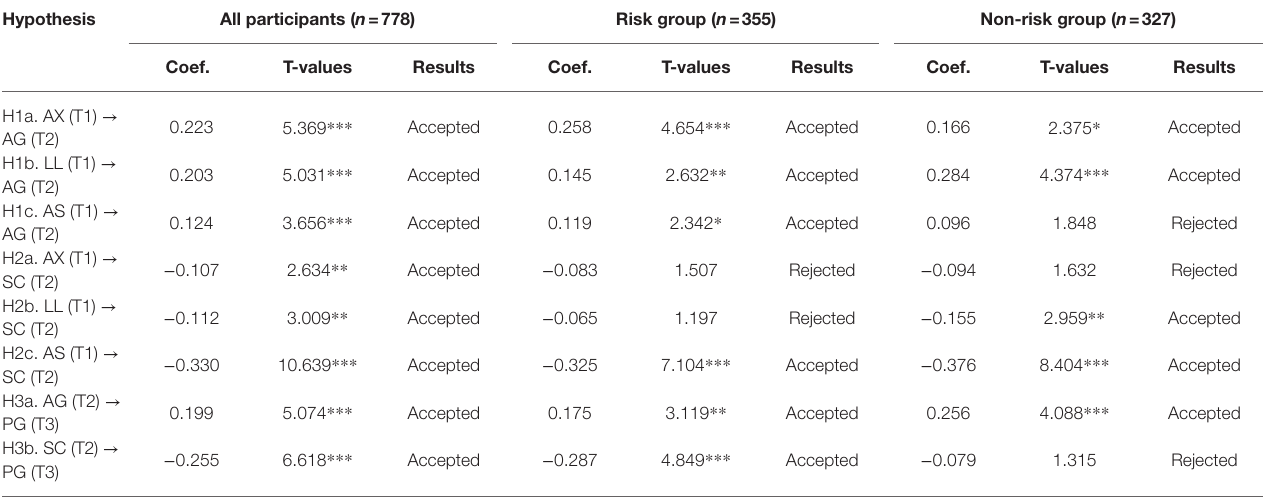
TABLE 5 | Hypothesis test results (direct